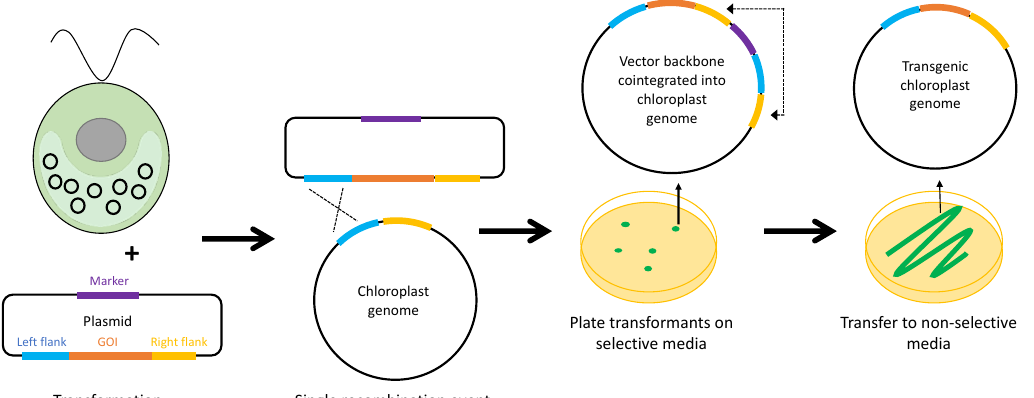
Figure 7. Co-integration of a selectable marker. The marker is placed outside of the flanking regions in the transformation plasmid, within the vector region. Upon transformation, an initial, single recombination event results in co-integration of the whole plasmid, including the marker, into the plastome. Antibiotic selection for the marker allows the maintenance of the unstable co-integrated state, but, once the selective pressure is removed, a second recombination between a pair of homologous elements is favoured, resulting in one of two possible outcomes: recombination between the original elements (in blue) and loss of the whole plasmid restoring the wild-type plastome, or recombination between the second elements (in yellow) to create a transgenic line containing just the GOI. The latter is identified by PCR [97].